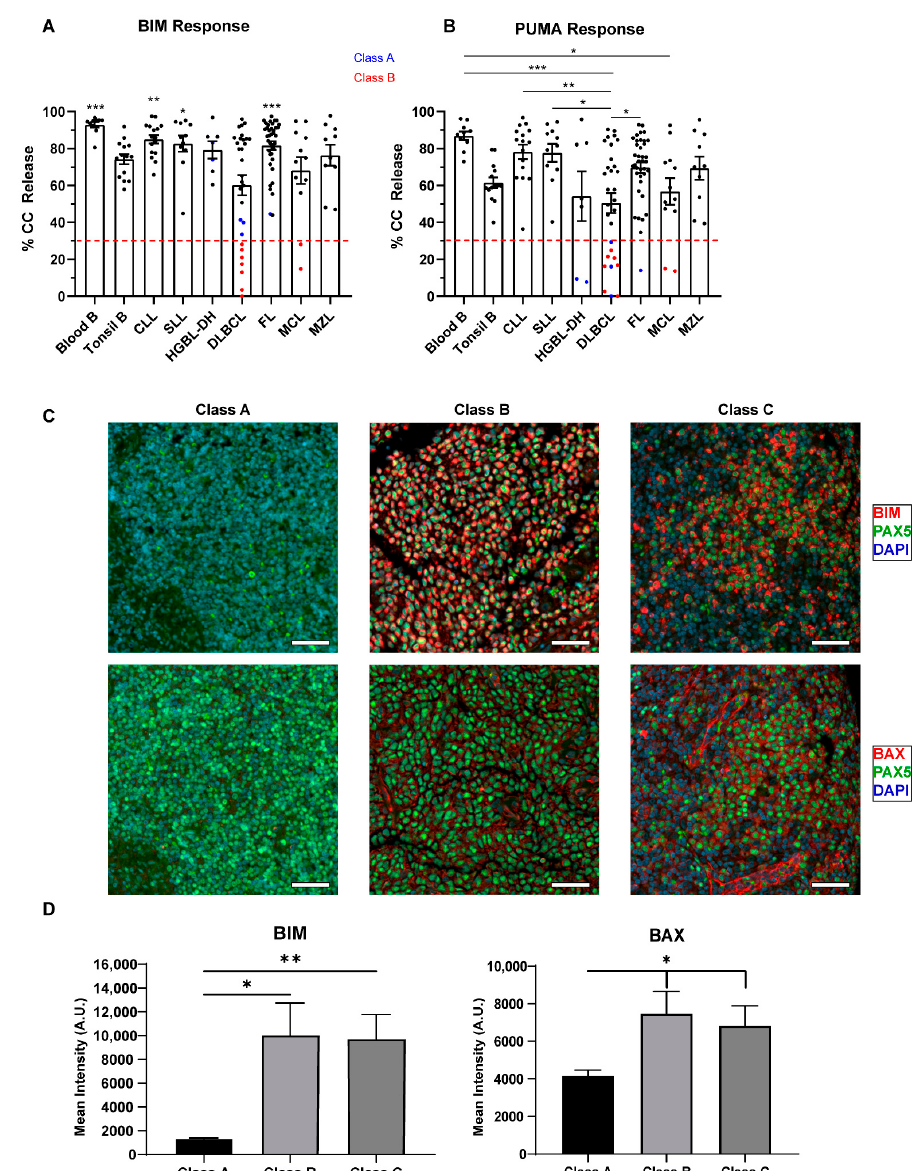
Figure 3. Competency and priming of the mitochondrial pathway according to lymphoma subtype. We measured cytochrome c release, displayed on the y -axis, after exposure to 100 µ M of BIM ( A ) and 100 µ M of PUMA ( B ) peptides in different untreated lymphoma subsets (10 frozen blood B, 14 tonsil B, 16 chronic lymphocytic leukemia (CLL), 11 small lymphocytic leukemia (SLL), 7 high-grade B cell lymphomas with translocations in MYC and BCL2 (HGBL-DH), 30 DLBCL, 38 follicular lymphoma (FL), 12 mantle cell lymphoma (MCL), 10 marginal zone lymphoma (MZL)). For BIM, we defined a threshold of <30% as having a class B block, i.e., having dysfunctional BAX or BAK. For PUMA, we defined a threshold of <30% as being unprimed. Red dashed lines highlight the 30% cut-off, with samples below this threshold being class A/B apoptotic blocks. Class A block samples are in blue and class B block samples are in red. Dots represent individual samples, bars represent the mean ± standard error of the mean (SEM). A one-way ANOVA with Tukey multiple comparison was used to determine statistical significance between non-Hodgkin lymphoma (NHL) subtypes. Only comparison to DLBCL was determined to be significantly different in BIM response. DLBCL samples are less primed than other NHL and high-grade lymphomas have a higher percentage of class A/B blocks. * p < 0.05, ** p < 0.01, *** p < 0.001. ( C ) Representative merged IF stains at 20 × for DAPI (blue), PAX5 (green, AF594) and BIM/BAX (red, AF647) in class A, B, and C DLBCL samples. Scale bars represent 50 µ m. ( D ) Quantification of the mean pixel intensity across all classes of apoptotic block in DLBCL. Samples were analyzed using Qupath software and t-test with Welch’s correction was used to compare columns, bars represent the mean ± standard error of the mean (SEM). * p < 0.05, ** p < 0.01. Class A samples may have decreased expression of BIM and possibly BAX compared to Class B and C